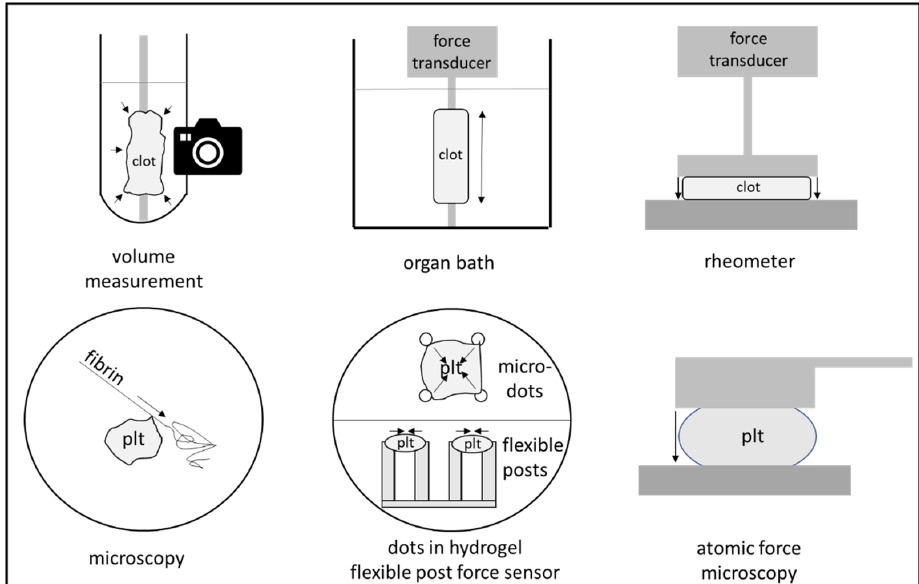
Figure 2. Methods for the measurement of clot retraction. Macro-methods ( upper row ) include the observation of the clot retracting in a vial, the measurement of force development of a molded clot in an organ bath, and the use of a rheometer. Micro-methods (see lower row ) include the microscopic observation of platelet (plt) movement, the observation of traction of microdots in a hydrogel, or the flexion of flexible post force sensors as well as the use of atomic force microscopy.